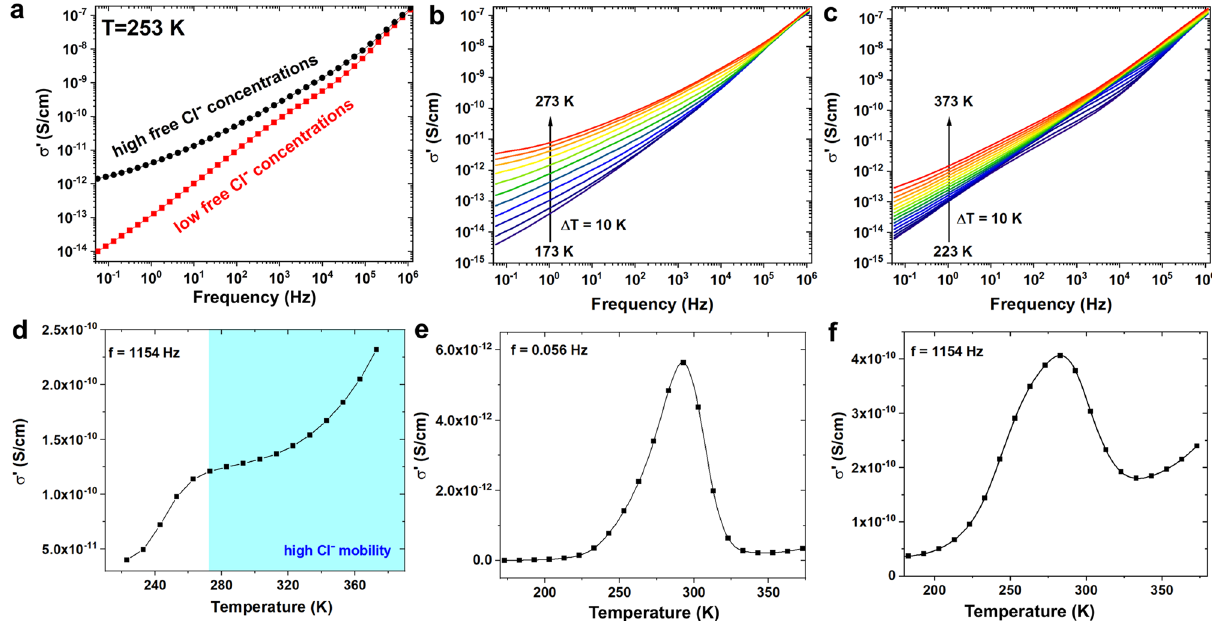
Figure 5. ( a ) Real part of complex conductivity measured for BiOCl before (black points) and after preheating (red points) at 253 K; the influence of temperature on the real part of complex conductivity for BiOCl before ( b ) and after preheating ( c ); ( d ) σ ′ (T) relationship measured at 1154 Hz for BiOCl after preheating; σ ′ (T) relationship at 0.056 Hz ( e ) and 1154 Hz ( f ) for BiOCl before